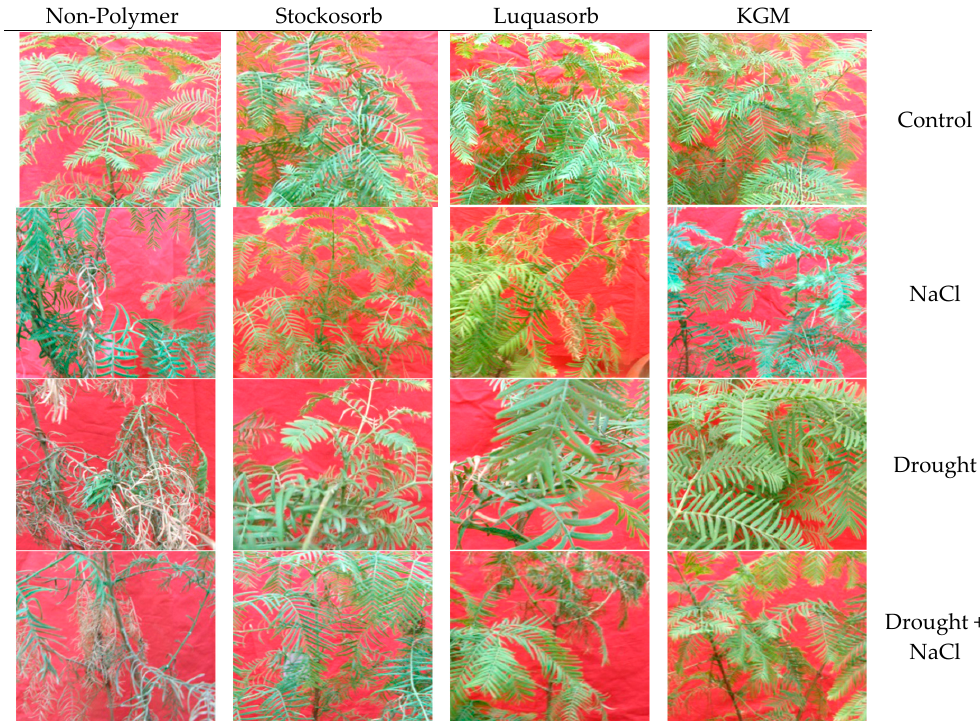
Figure 1. Images of Metasequoia glyptostroboides Hu and W.C.Cheng test plants subjected to drought and saline stress after 20 days. Columns indicate soils amended without (Non-Polymer) or with synthetic (Stockosorb, Luquasorb) and natural (Konjac glucomannan, KGM) hydrophilic polymers. Rows indicate M. glyptostroboides seedlings subjected to control, salt exposure, drought, and combined salt and drought exposure (see Materials and Methods section).